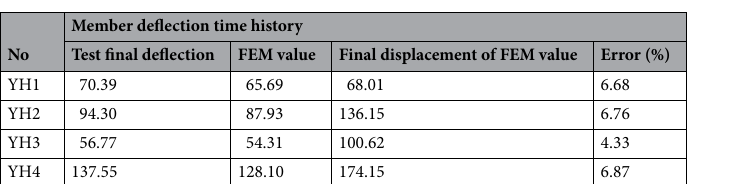
Table 4. Deflection time history comparison between FEM and test values. Error ( % ) =